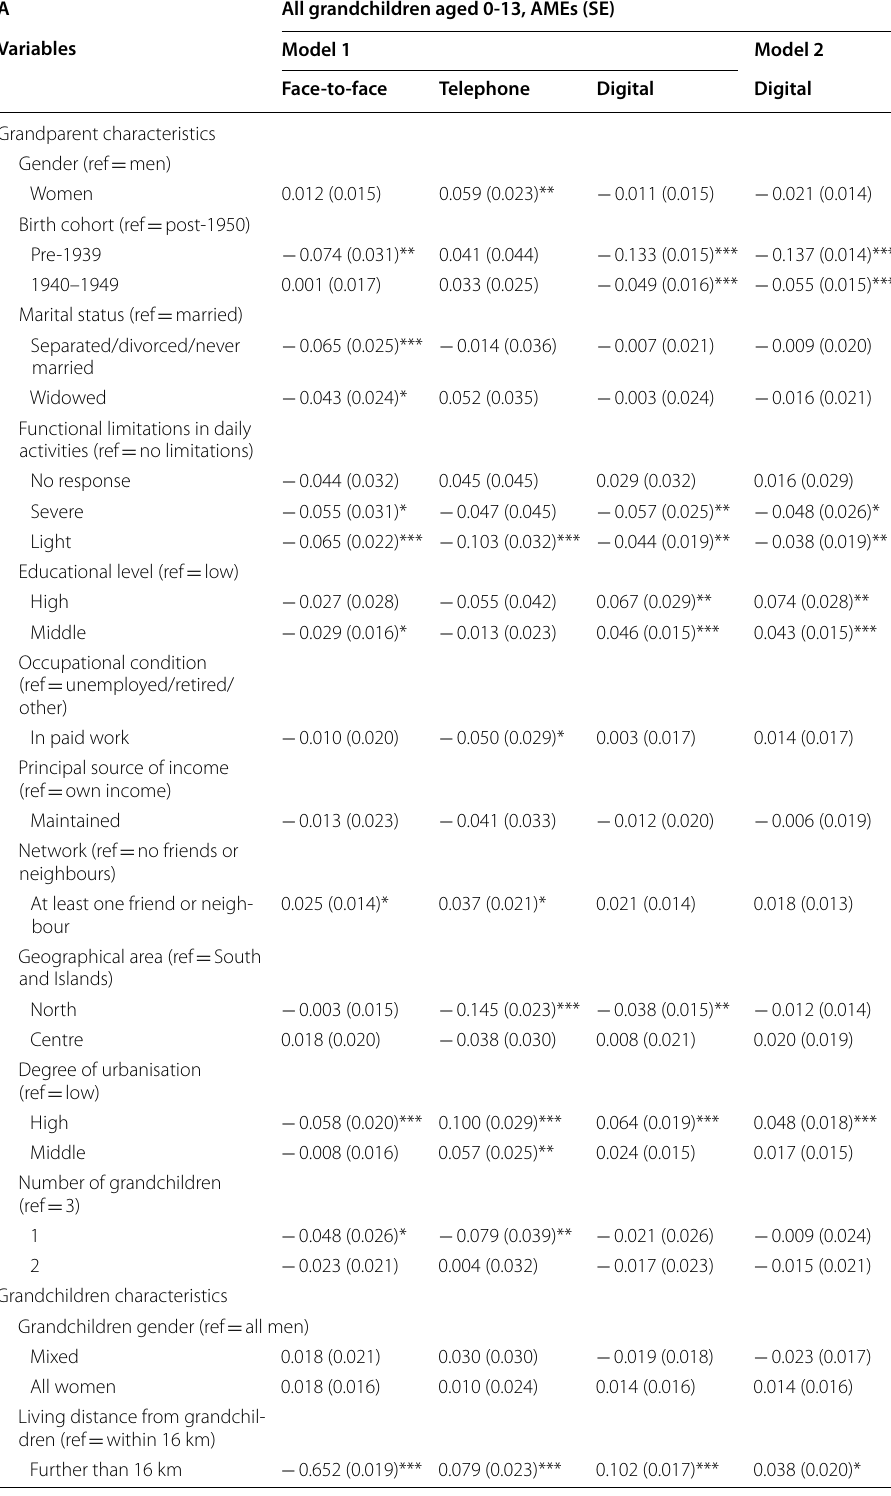
Table 4 Average marginal effects and robust standard errors from logistic regression models of grandparent–grandchild contact, for grandparents stratified by grandchildren’s age: